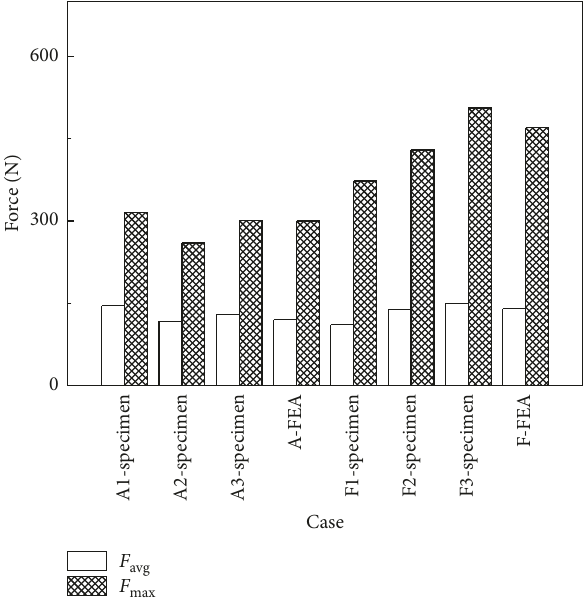
Figure 11: Comparison of different stacking sequence for speci- mens: F max and F avg